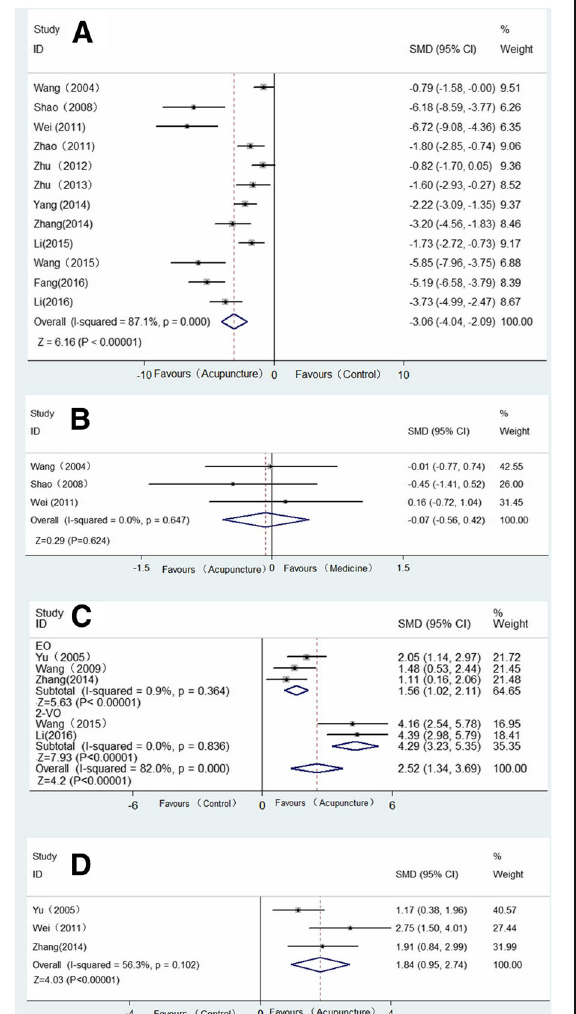
Fig. 2 Forest plot showed that escape latency decreases with acupuncture therapies in vascular models. Effect of acupuncture on outcomes of the water maze: effect on ( a ) escape latency time versus the control group; ( b ) escape latency time versus nimodipine; ( c ) duration in original platform; ( d ) frequency of crossing former